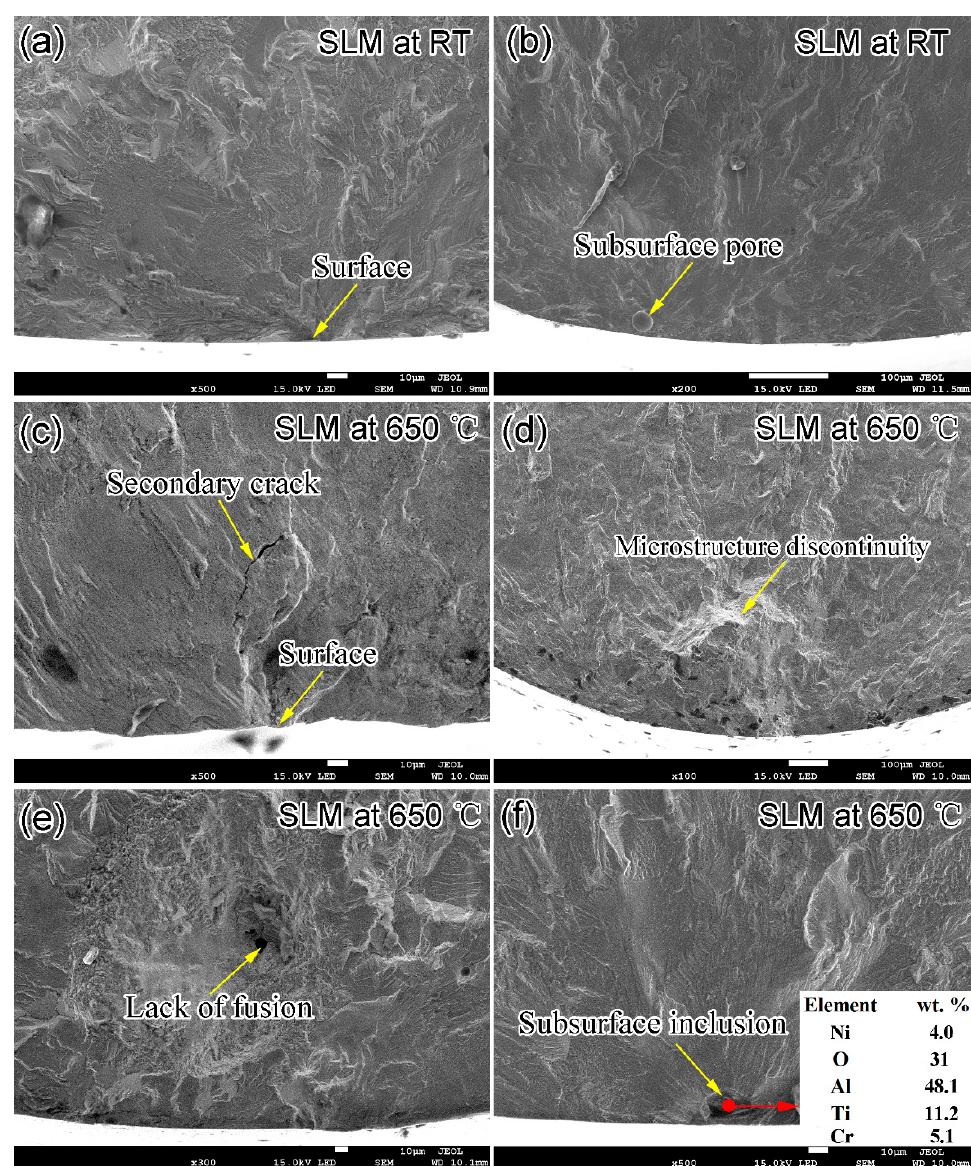
Figure 7. Representative SEM fractographic images of SLM IN718 specimens tested at ( a , b ) RT and (c-d) 650 °C: ( a ) σ a = 570 MPa, N f = 4.4 × 10 5 ; ( b ) σ a = 480 MPa, N f = 3.1 × 10 8 ; ( c ) σ a = 472 MPa, N f = 2.3 × 10 7 ; ( d ) σ a = 420 MPa, N f = 2.9 × 10 8 ; ( e ) σ a = 444 MPa, N f = 2.3 × 10 8 ; ( f ) σ a = 416 MPa, Nf = 9.4 × 10 8 .